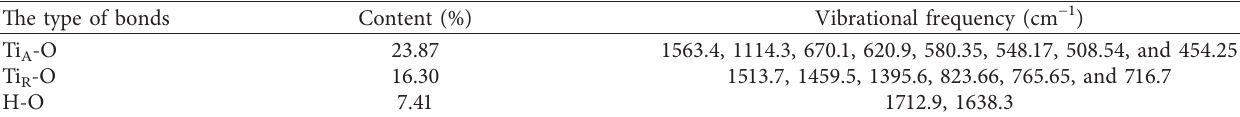
2 samples at calcination temperature (550 2 samples with the content and vibrational frequency of valence bonds.